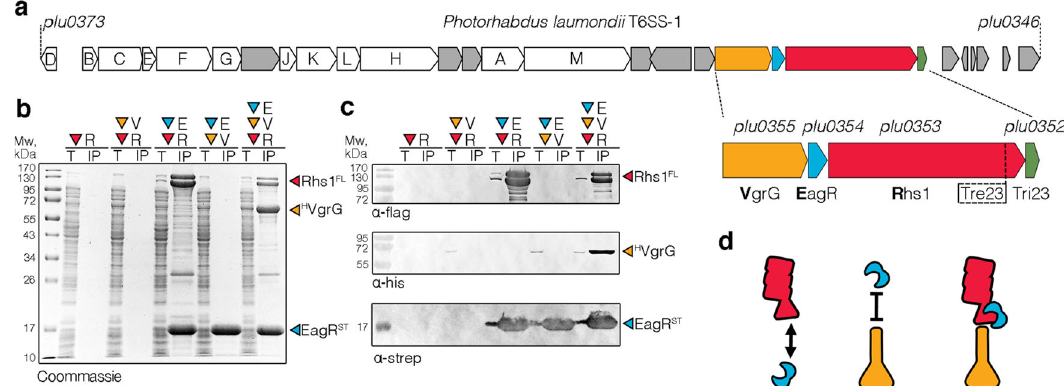
Fig. 1 Rhs1 mounting on the VgrG spike. a Schematic representation of the Photorhabdus laumondii T6SS gene cluster. Genes encoding T6SS core components of T6SS are identi fi ed by their Tss corresponding letter (e.g., A for TssA). A close-up emphasizing the vgrG-eagR-rhs1-imm1 genetic locus is shown below ( vgrG , orange; eagR , blue; rhs1 , red; tri23 , green). b and c Pull-down assays. Total cell extracts (T) from E. coli BL21(DE3) cells producing various combinations of His 6 -tagged VgrG ( H VgrG, V), Strep-tagged EagR ( ST EagR, E), and FLAG-tagged Rhs1 (Rhs1 FL , R) were subjected to puri fi cation on streptactin-agarose beads. Strep-tagged and co-precipitated proteins were eluted with desthiobiotin (IP). Total and IP fractions were analyzed by SDS- PAGE and co-puri fi ed proteins were stained by Coomassie blue ( b ) or immunodetected using anti-His, anti-Strep, and anti-FLAG antibodies ( c ). Molecular weight markers (Mw, in kDa) are indicated on the left. Pull-down assays have been performed at least in triplicate, and a representative experiment is shown. d Schematic representation of the VgrG (orange), EagR (blue), and Rhs1 (red) interaction network based on pull-down